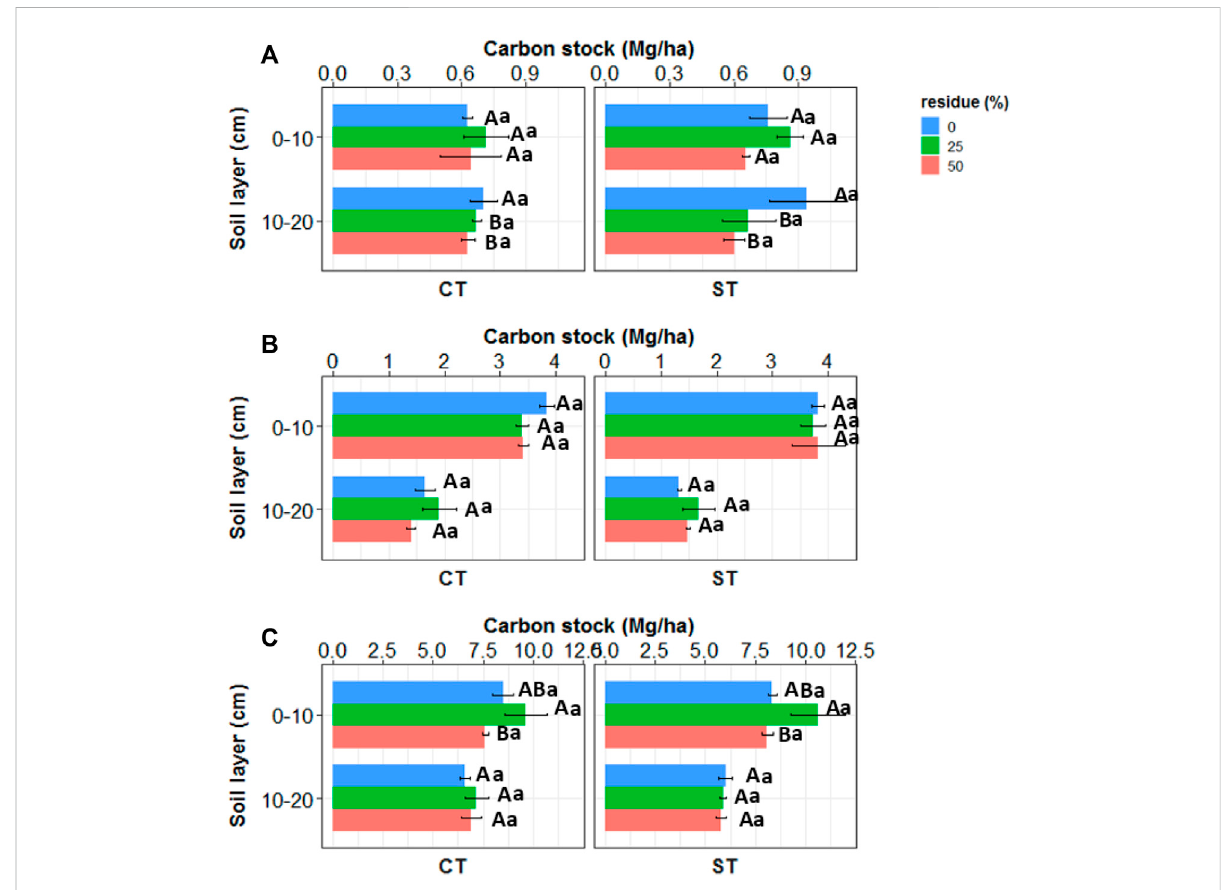
FIGURE 8 CarbonstockinfractionationcontributedbylightPOM (A) ,heavyPOM (B) andMAOM (C) at0 – 10and10 – 20 cmpro fi ledepthsatmaizeharvest in 2020 – 21. For treatment, details refer to Table 2. Different upper-case letters represent signi fi cant intragroup statistical difference at p ≤ 0.05; Different lower-case letters represent signi fi cant intergroup statistical difference at p ≤ 0.05; p values calculated by the ANOVA test and t